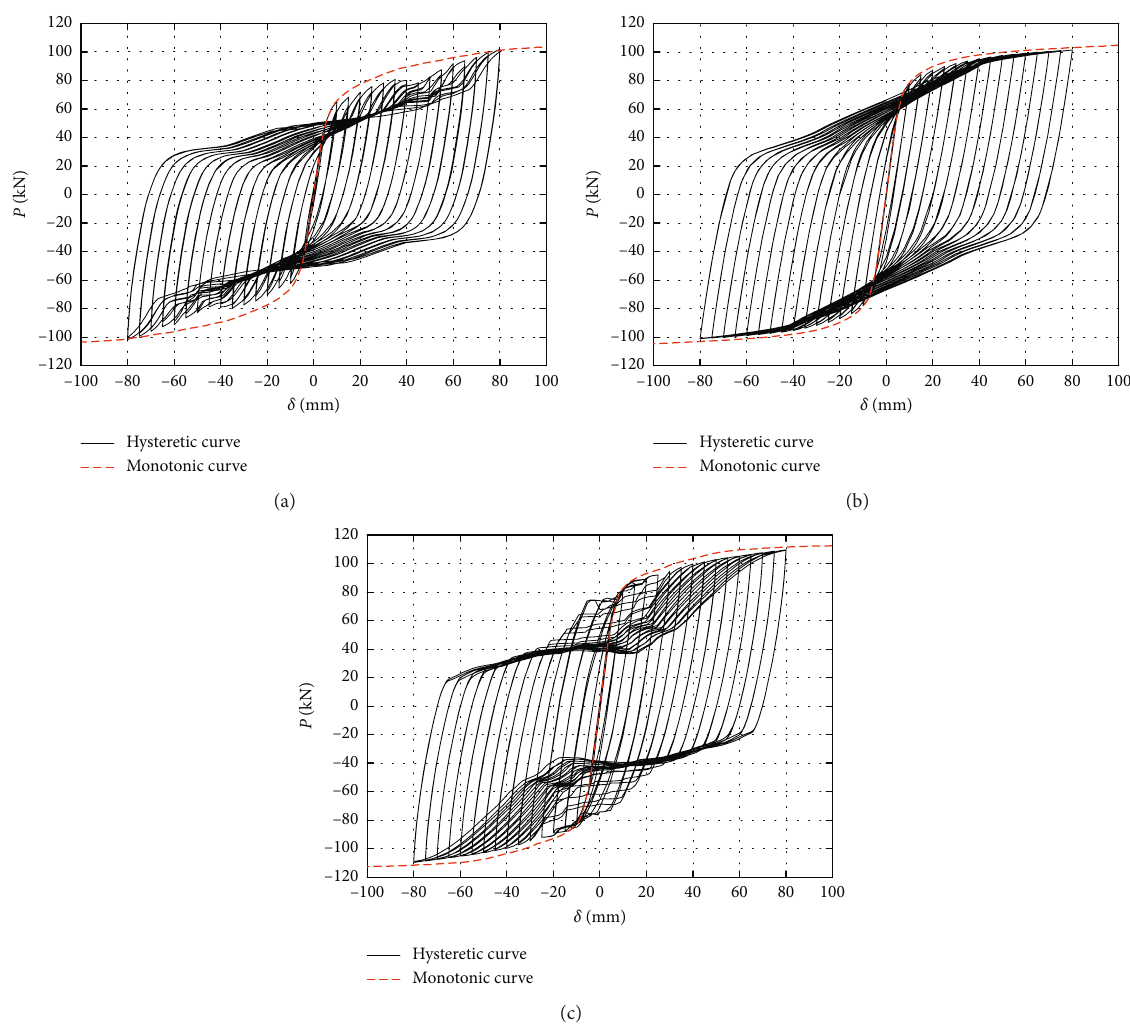
Figure 11: Hysteretic curves of the joints. (a) J-1. (b) J-2. (c) J-3.